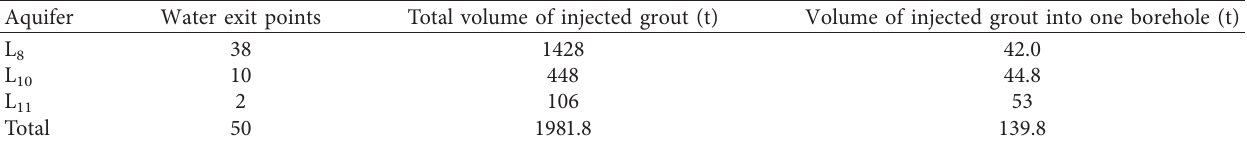
Table 5: Type II fracture.